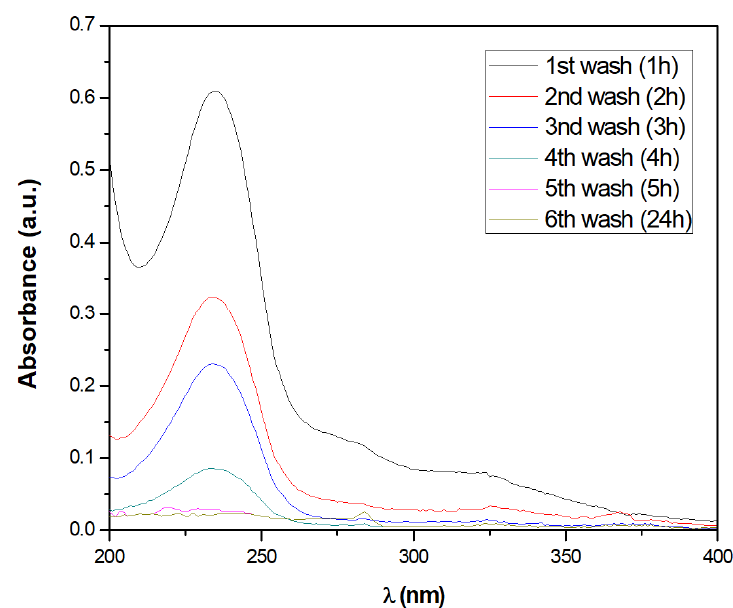
Figure 7. Evolution of absorbance spectra of the supernatant (washing solution) collected during the chitosan (cs) ‐ polyethersulfone (PES) MF022 membrane washing process.